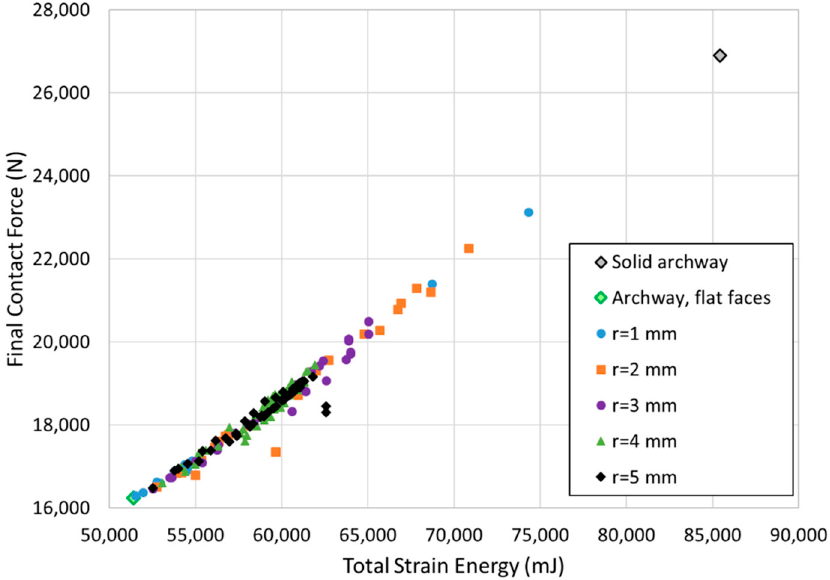
Figure 7. Final contact force vs. total strain energy for all cases.